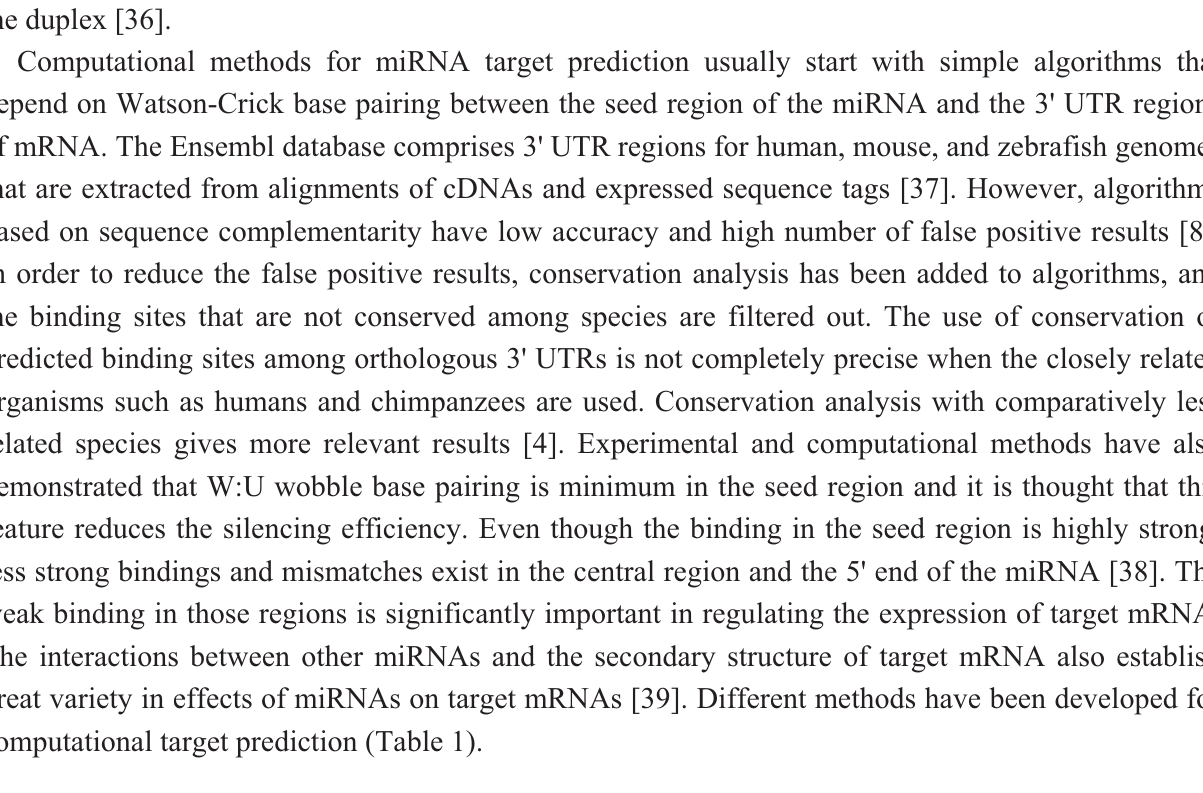
Table 1. The main algorithms for computational target